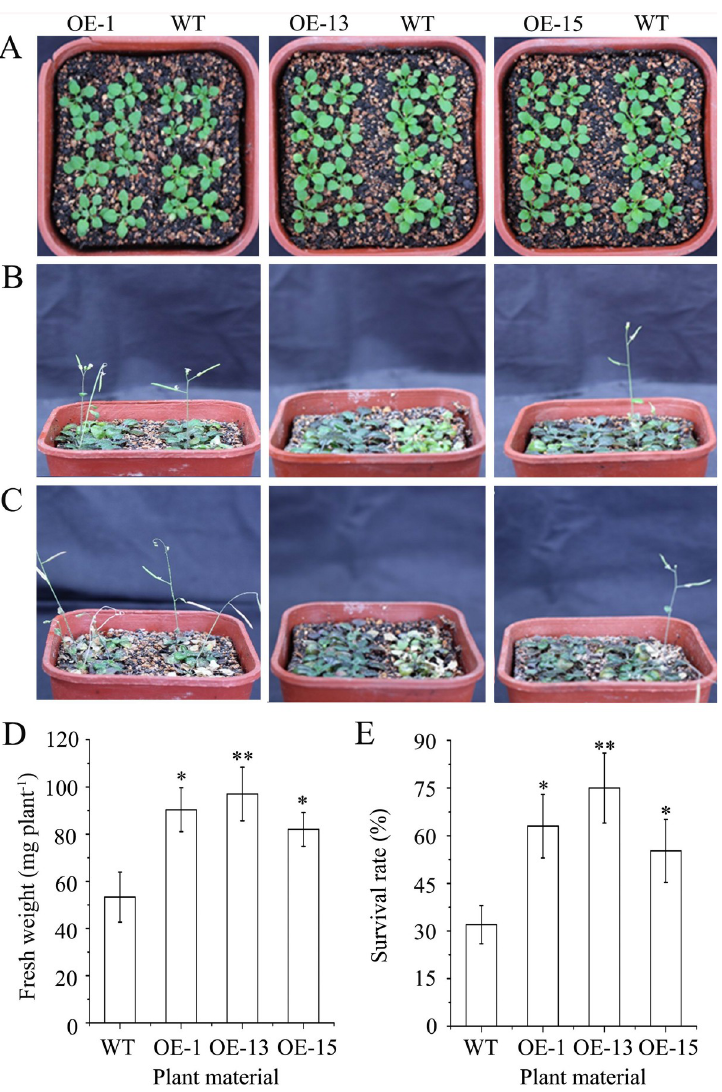
Fig 7. Constitutive expression of AmDREB3 enhanced salt tolerance of transgenic Arabidopsis at the seedling stage. Ten-day-old seedlings were watered with a 300 mM NaCl solution once and then were returned to their regular watering schedule of once every 5 d with tap water. (A, B and C) Plant phenotypes of the transgenic lines (OE-1, OE- 13, and OE-15) and wild-type (WT) Arabidopsis before, 7 d after, and 14 d after watering with the NaCl solution, respectively. (D and E) Fresh weights and survival rates of plants after 7 d and 14 d of watering with the NaCl solution, respectively. Data are presented as means ± SDs (n = 3). Asterisks and double asterisks indicate significant differences of transgenic lines (OE-1, OE-13, and OE-15) compared to wild-type (WT) at p < 0.05 and < 0.01, respectively.